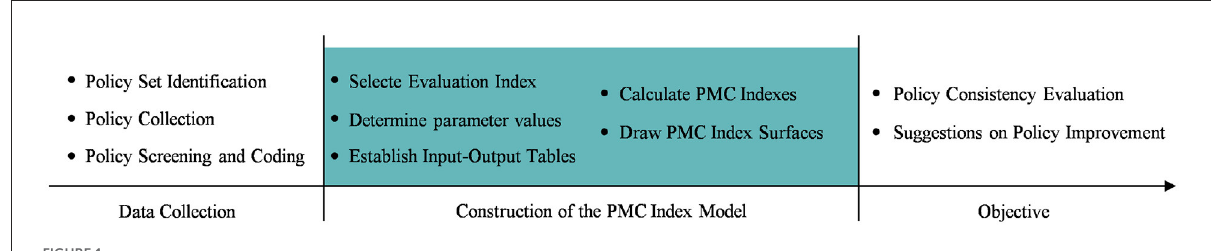
FIGURE1 Construction framework for the PMC index